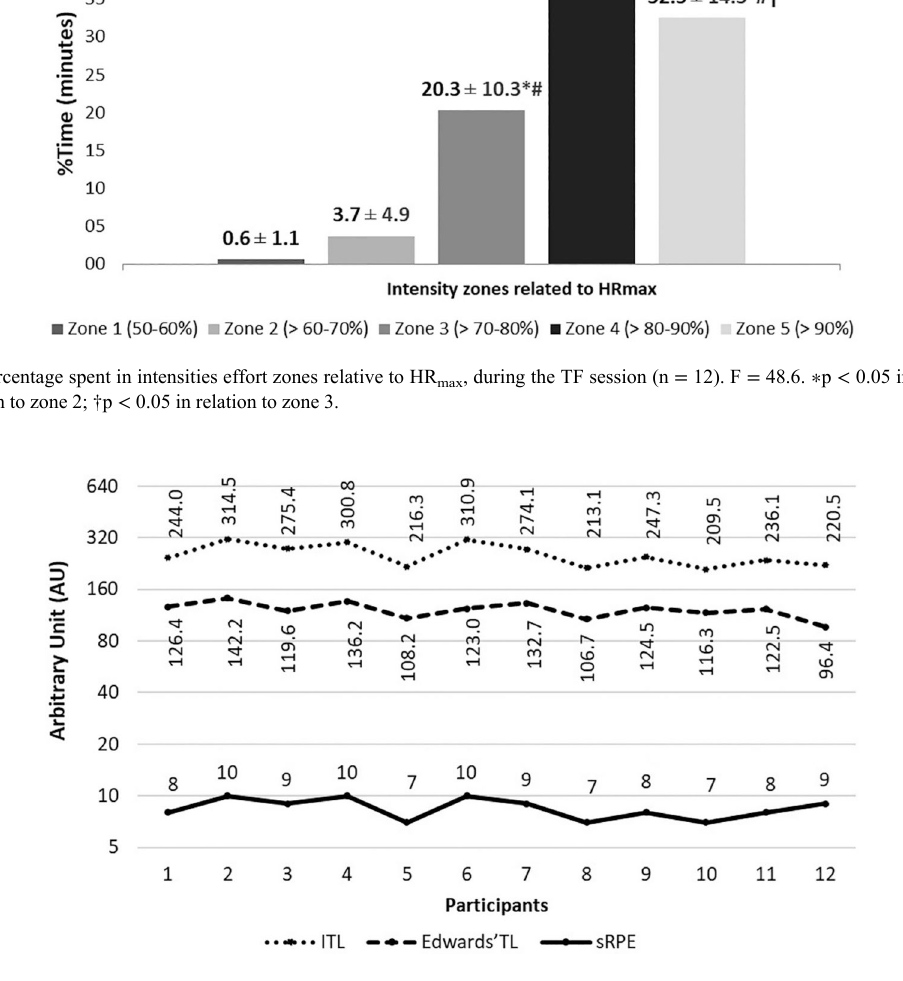
Figure 2 - Individual sRPE, ITL and TRIMP quantification in the FT SESSION .